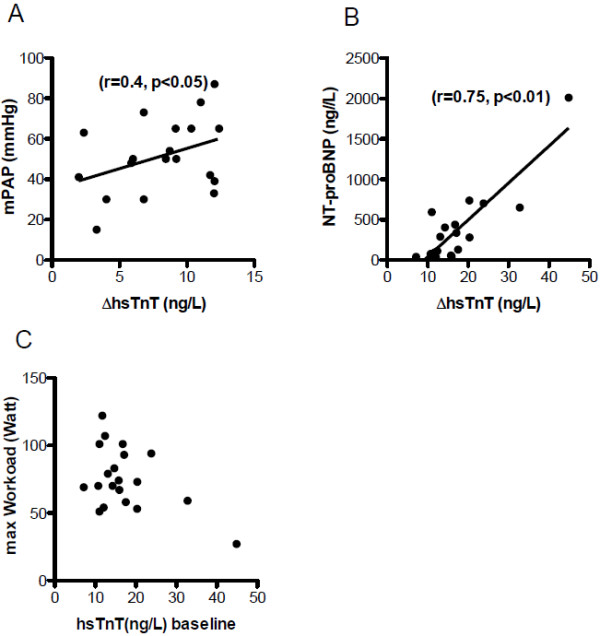
Correlation between ∆ hsTnT and clinical parameters. Correlation between ∆ hsTnT and mPAP (A) and NT-proBNP (B) showed positive correlation whereas ∆ hsTnT and maximal Workload (C) showed no correlation.